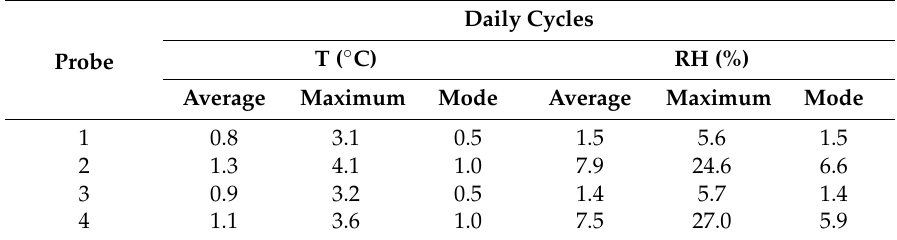
Table 2. Daily cycles of T and RH data collected from each probe, expressed in terms of average, maximum and mode of the daily T and RH spans inside (probes 1 and 3) and outside (probes 2 and 4) the microclimate frames.